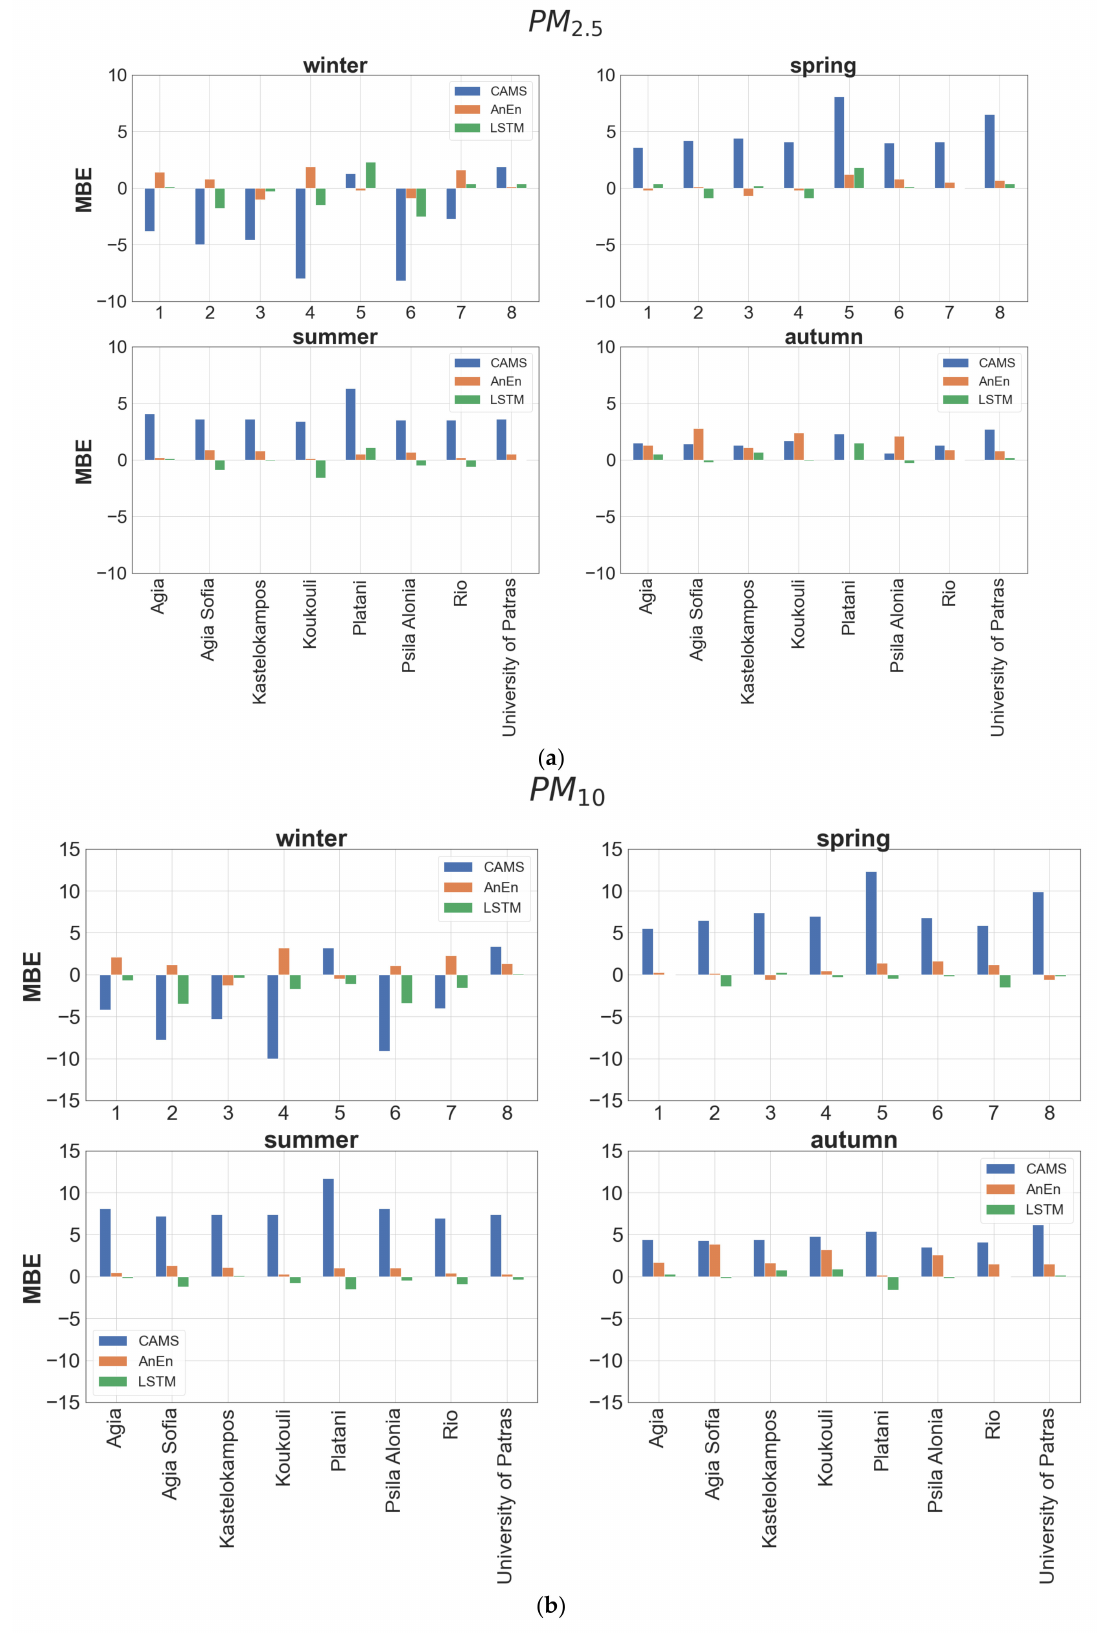
Figure 8. Seasonal bar plots of MB values between CAMS forecasts (blue), AnEn (red) and LSTM (green) against observed values for ( a ) PM 2.5 and ( b ) PM 10 at each